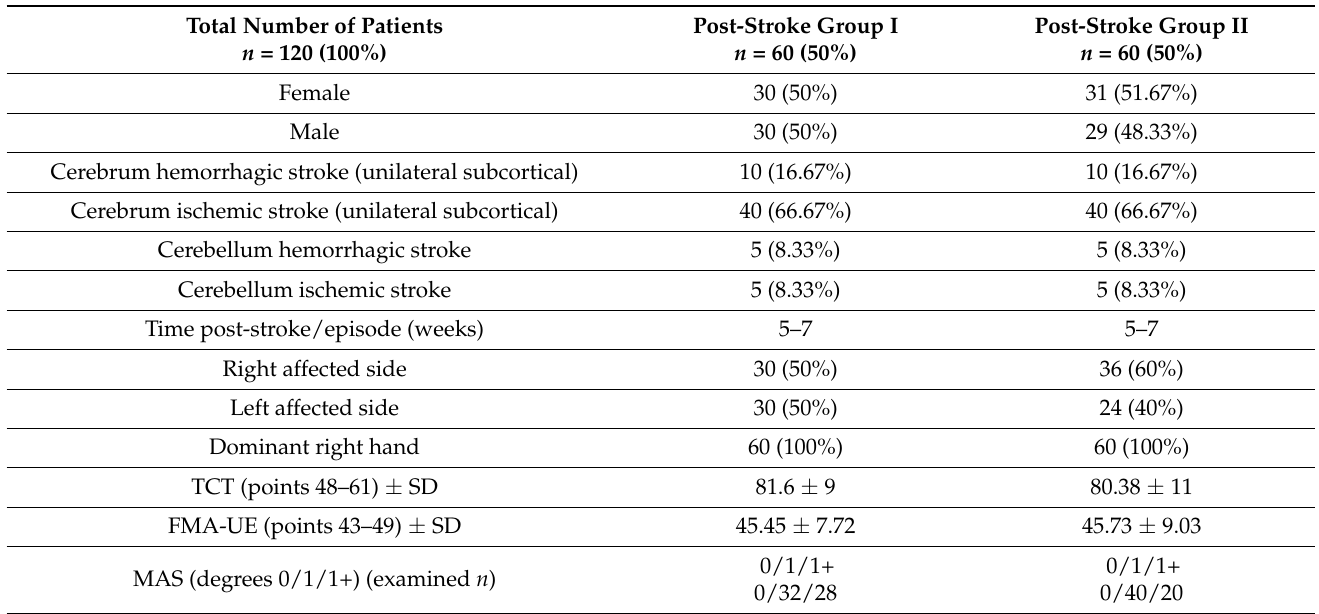
Table 3. Epidemiological data of post-stroke